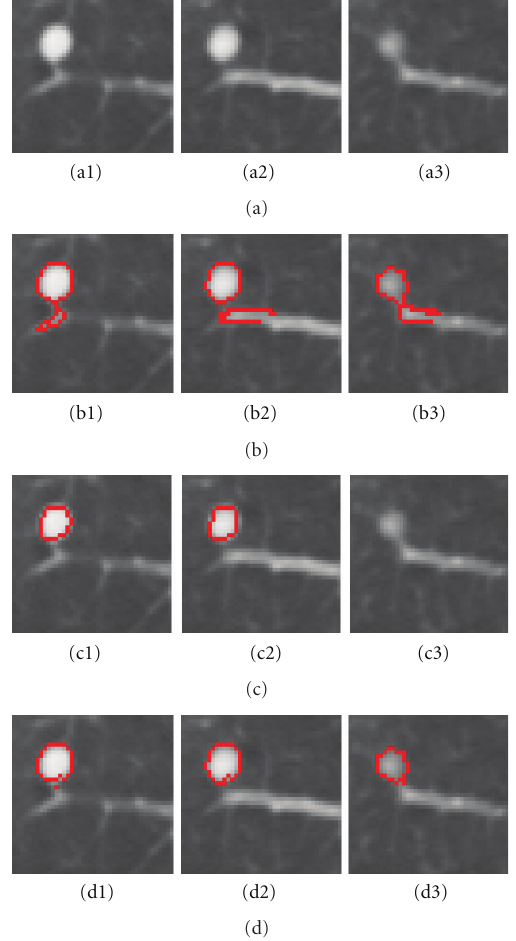
Figure 6: Schematic diagram of di ff erent types of superpixels: foreground (green) superpixels, background (red) superpixels, and uncertain (gray) superpixels.